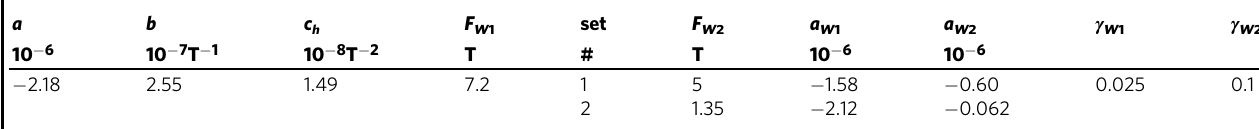
Values of a W 1 and a W 2 are found with Eqs. (10) from the coef fi cients of the polynomial a + bB + c h B 2 that approximates the experimental data on the magnetostriction at B >8